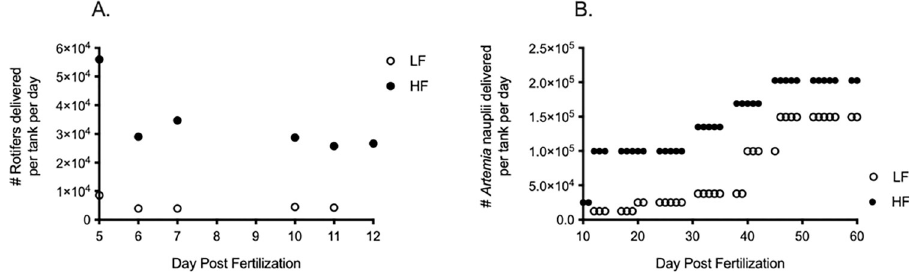
Fig 1. Rotifer & Artemia delivery per tank per day. (A) Daily rotifer concentration delivered per growth treatment, excluding weekends (day 8 & 9). Open circles = LF, closed squares = HF. (B) Daily Artemia nauplii delivered per growth treatment, excluding weekends. Open circles = LF, closed squares =